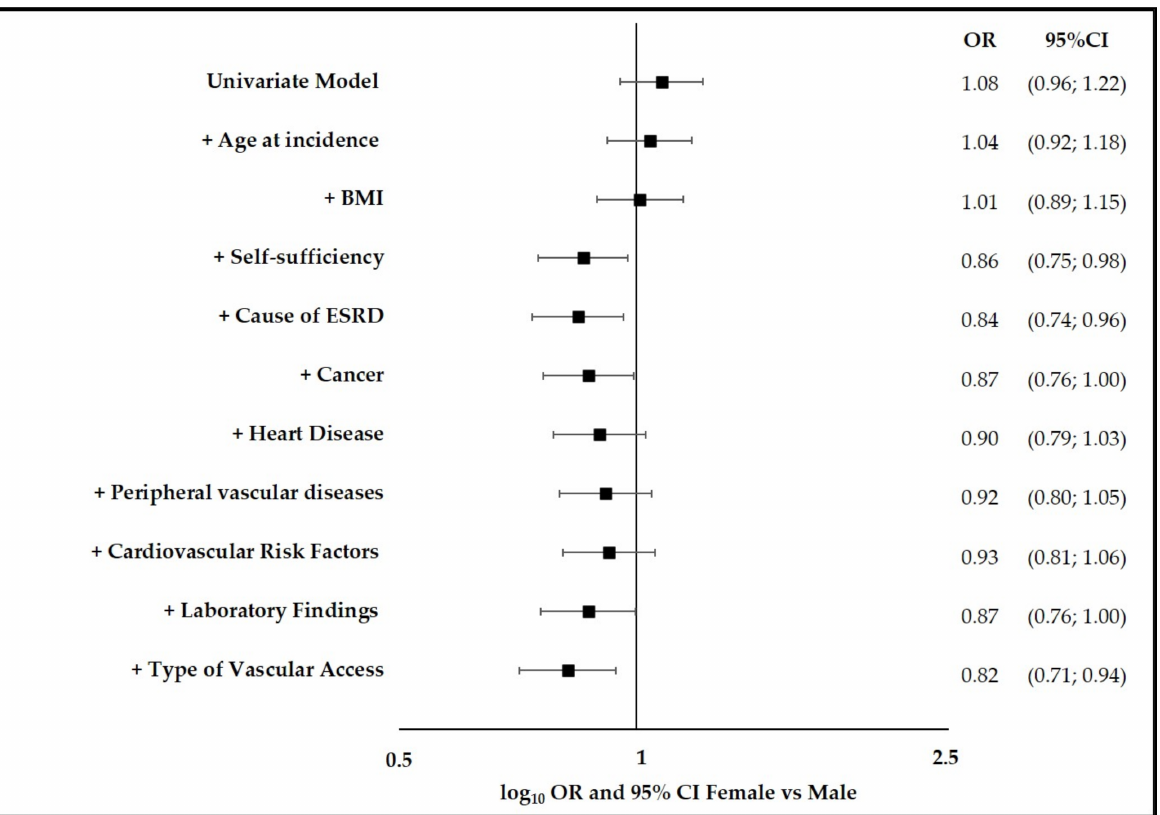
Figure 1. Univariable and adjusted OR for female to male mortality risk in incident hemodialysis patients from RRDTL Lazio Region (Italy) 2008–2017. RRDTL, the Regional Dialysis and Transplantation Registry, BMI, body mass index; ESRD, end-stage renal disease; OR, odds ratio; CI, confidence interval. Laboratory findings: serum creatinine, serum albumin, Hb. Cardiovascular risk factors: hypertension, obesity,